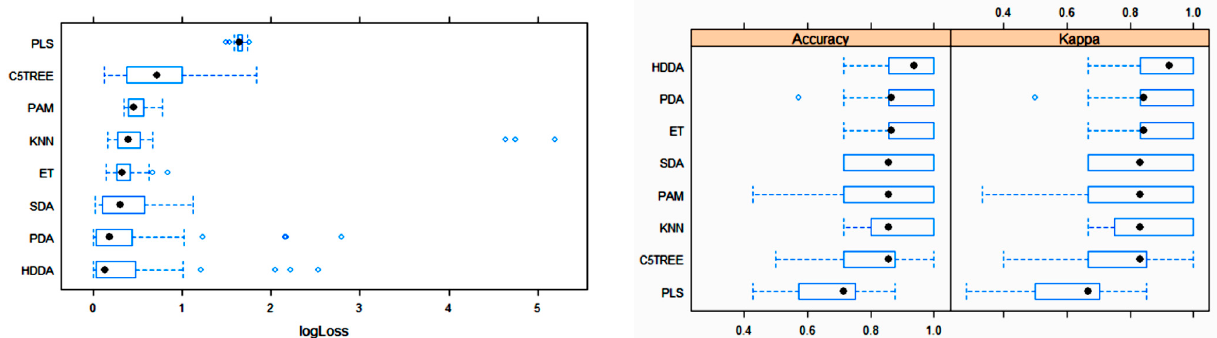
Figure 4. Box plots of log loss, accuracy and kappa values for various machine learning (ML) algorithms after training with 10-fold cross-validation to obtain the best model using the training dataset. Black circles symbolize mean values. PLS: partial least squares; C5TREE: C5.0 tree; PAM: nearest shrunken centroids; KNN: weighted k-nearest neighbors; ET: extremely randomized trees; SDA: shrinkage discriminant analysis; PDA: penalized discriminant analysis; HDDA: high-dimensional discriminant analysis.